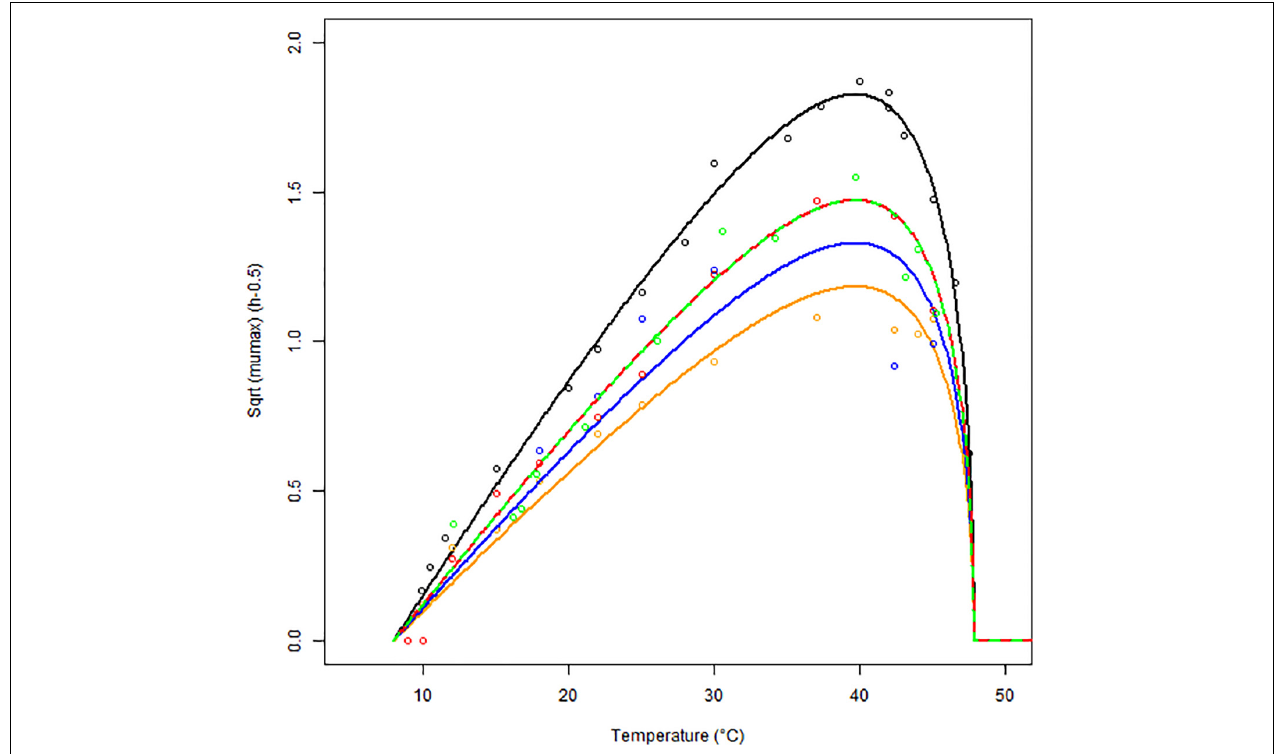
FIGURE 3 | Secondary models (continuous lines) fitted to the maximum specific growth rates of B. cereus strain F4810/72 (empty symbols) as a function of temperature ( ◦ C) for BHI (black), cereal- (orange), dairy- (blue), meat- (red), and vegetable-based matrices (green). The Square Root (Sqrt) link function was used.